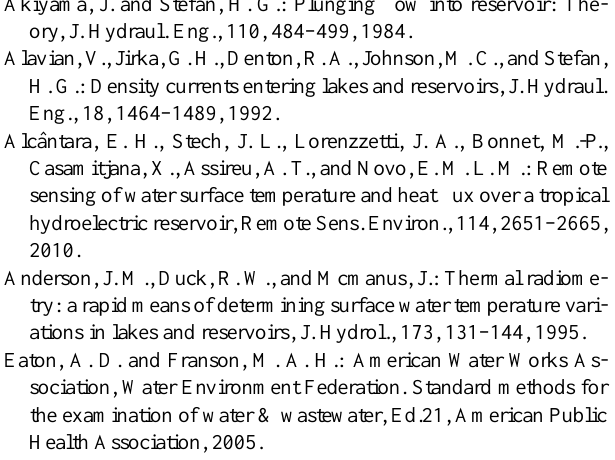
Figure 12: Temperature contours from the thermistor-chain data measured near the dam (January) (Station 08). Fig. 12. Temperature contours from the thermistor-chain data mea- sured near the dam (January) (Station